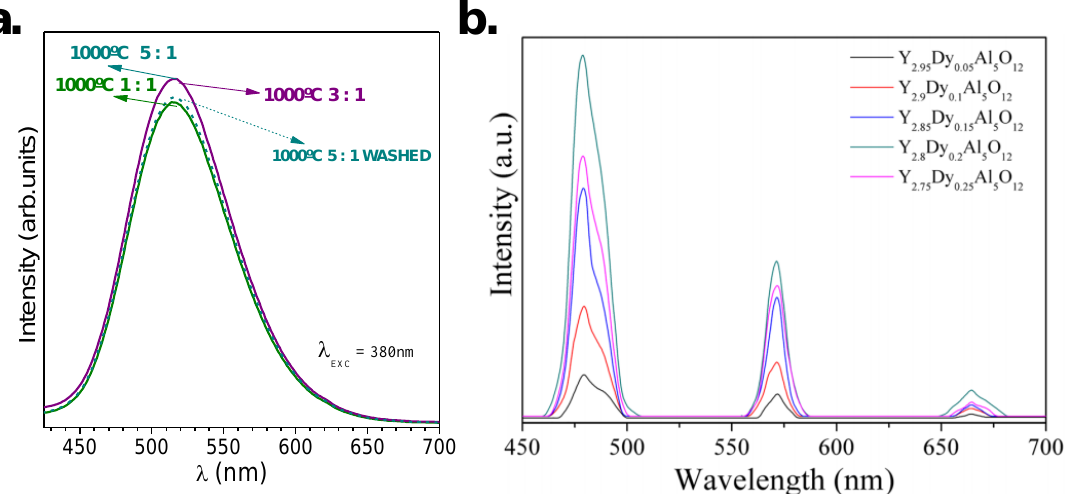
Figure 3. ( a ) Photoluminescence emission spectra as a function of the salt/SrAl 2 O 4 molar ratio of 1:1, 3:1 and 5:1 of SrAl 2 O 4 :Eu, Dy phosphor synthesized at 1000 °C before and after washing. ( b ) The emission spectra of Dydoped yttrium aluminum garnet using different Dy concentrations, after washing 12 times. Reprinted with permission from [36]. Copyright 2019, John Wiley and Sons.